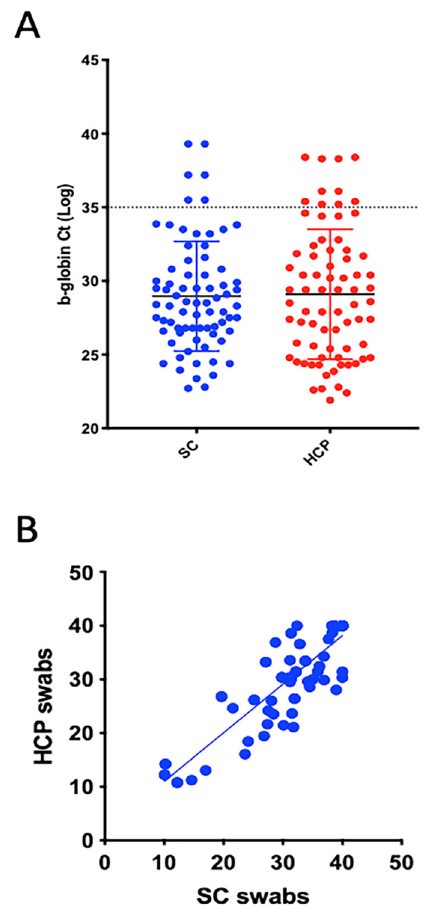
Figure 3. Graphical representation of SC and HCP swabs correlation. ( A ) Scatter plot showing the b-globin levels detected in self-collected (SC) and healthcare worker-collected (HCP) samples. Note that Ct values are above the cut-off value (35 Ct) in seven SC samples and 11 HCP samples. ( B ) Correlation of Ct values of viral genes (average) detected in SC and HCP swabs ( N = 75). Pearson’s correlation test, r = 0.8784 (CI 95% 0.8136–0.9216), p < 0.0001.